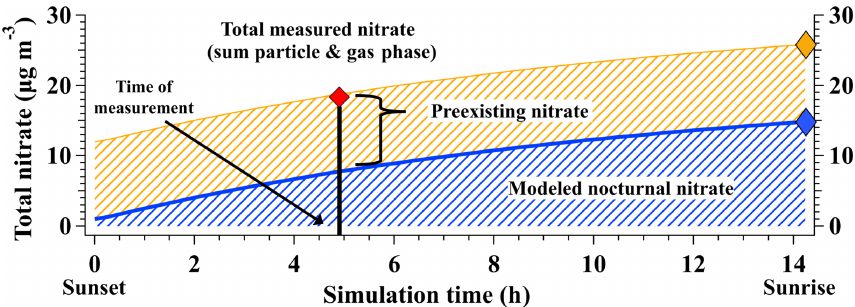
Figure 3. Example simulation of total nitrate production from sunset to sunrise for an air parcel sampled over the SLV on 28 January 2017. Model-derived γ( N 2 O 5 ) and ϕ( ClNO 2 ) values were 0.05 and 0.21, respectively. Modeled nocturnal nitrate (blue) is the total nitrate produced by heterogeneous chemistry in the box model, with the nocturnal production rate (µgm − 3 per night) represented by the blue diamond. Preexisting nitrate (yellow) represents the nitrate present at sunset and is calculated as the difference between total measured nitrate from the aircraft (red diamond) and the model-predicted nitrate at the time of aircraft measurement (vertical black line). Assuming preexisting nitrate is constant overnight (i.e., no deposition or dilution) and constant values of γ( N 2 O 5 ) and ϕ( ClNO 2 ) , total nitrate expected at sunrise is represented by the gold